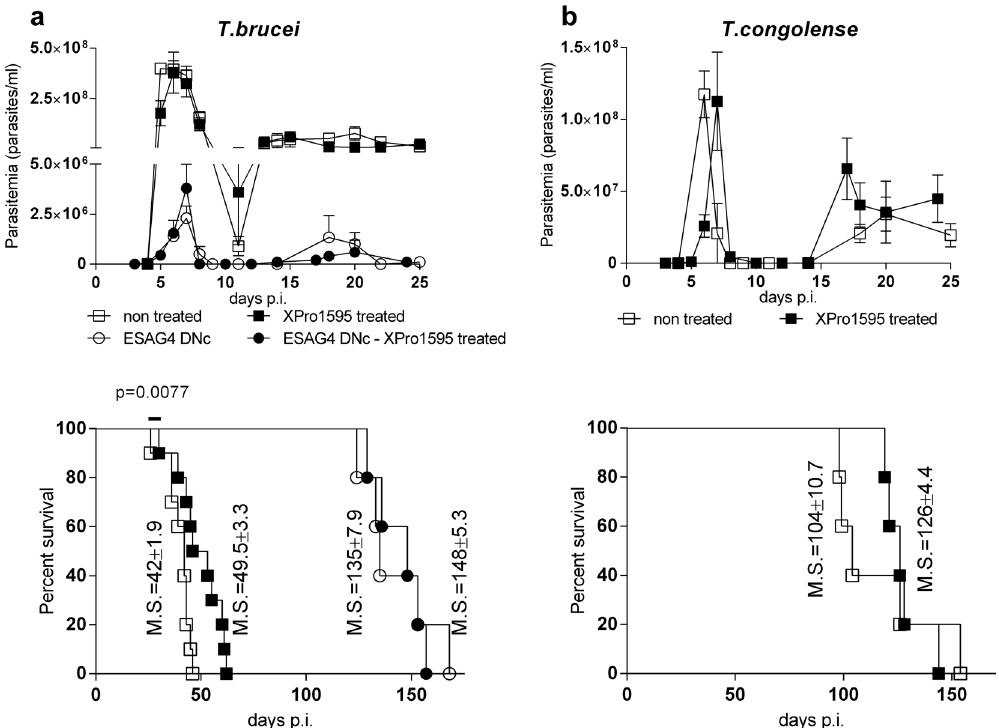
Figure 3. XPro1595 treatment on trypanosome parasitemia and mice survival. Parasitemia (upper panel) and survival time (lower panel) of C57Bl/6 mice either untreated (empty symbol) or treated (black symbol) with 10 mg/kg XPro1595 and infected with: ( a) T. brucei control (CTRL, squares) parasites (mean ± SEM, n = 10), parasites expressing a constitutively expressed DN ESAG4 construct (ESAG4 DNc, circles, mean ± SEM, n = 5), ( b ) T. congolense (mean ± SEM, n = 5). A significant, but small (1.179-fold increase, 95% CI 0.4905 to 2.832), increase (p-value = 0.0077 Log-rank test) of survival was observed for the CTRL infected mice after treatment with XPro1595. M.S. = median